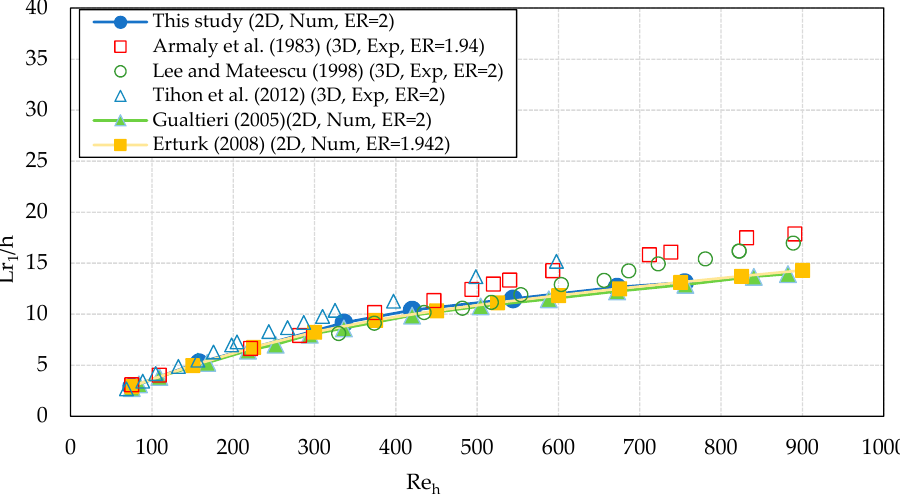
Figure 5. Dimensionless primary reattachment length Lr 1 /h vs. Re h in laminar flow (Exp, experimental study; Num, numerical study; 2D, two-dimensional; 3D, three-dimensional; ER, expansion ratio) [3,14,19,23,25].